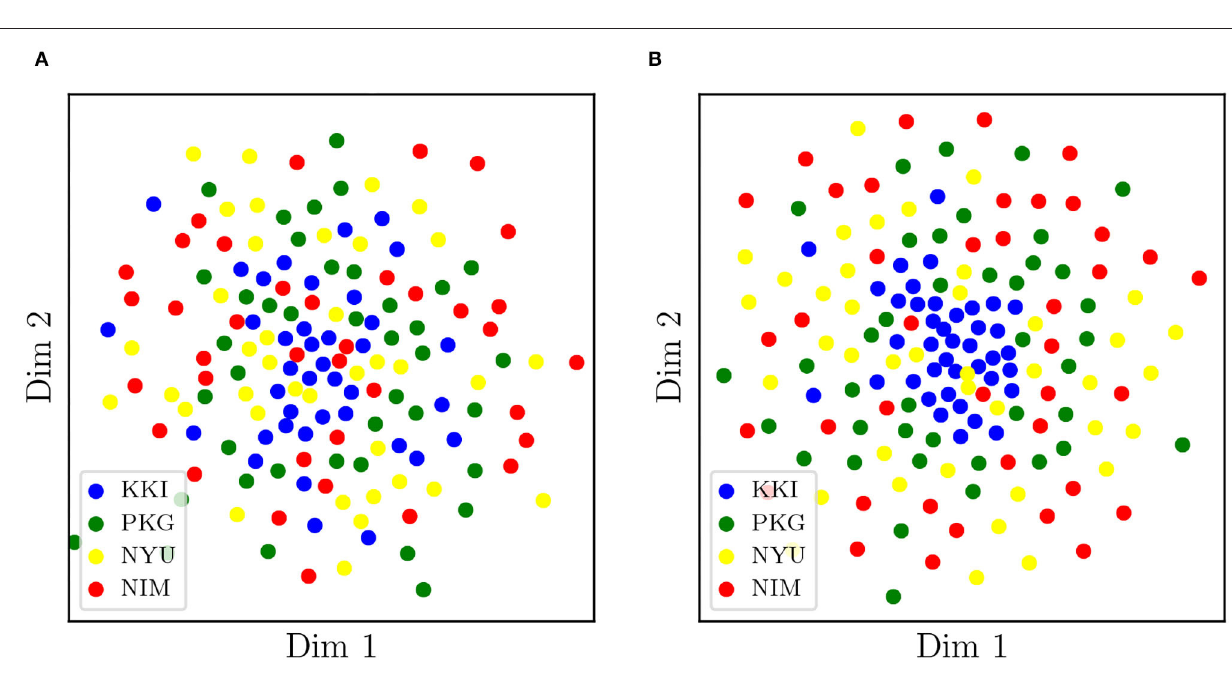
between RLET( I ) and MW, and between RLET( 6 ) and RLET( I